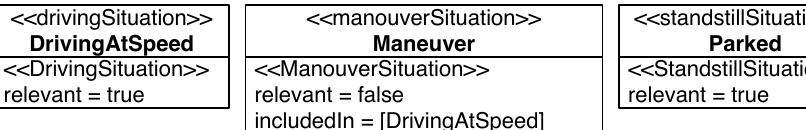
Figure 9. ESCL Situations based on